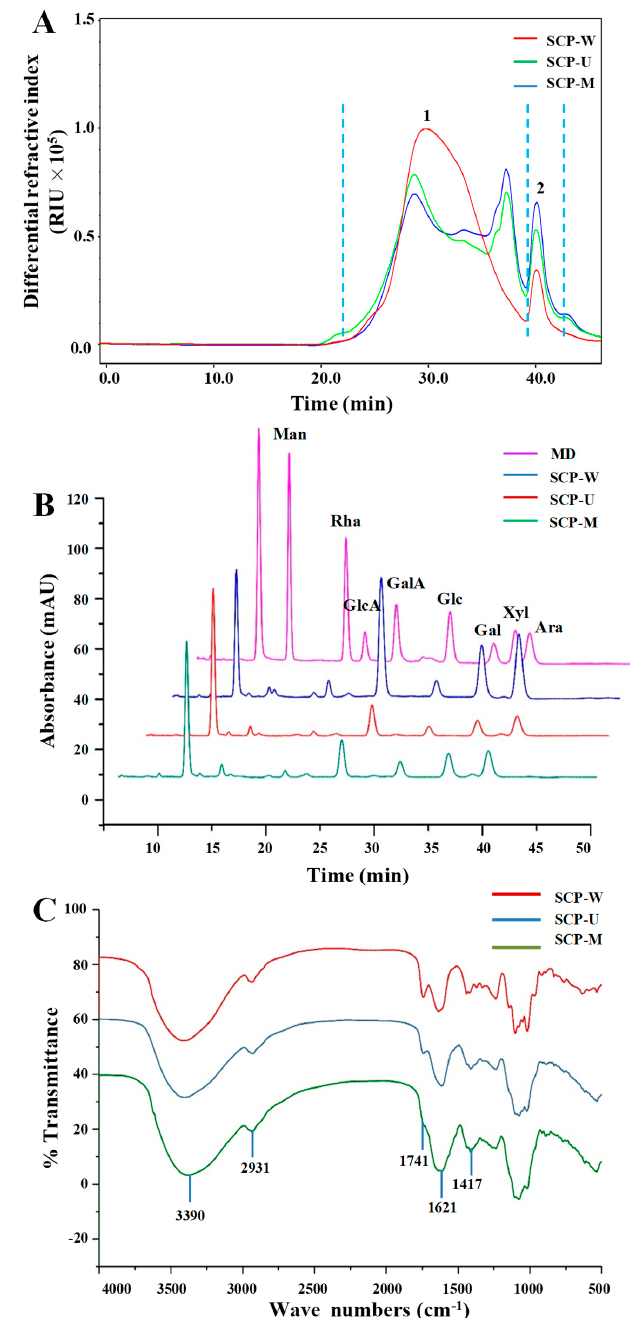
Figure 4. ( A ) High-performance size-exclusion chromatography (HPSEC) chromatograms, ( B ) high-performance liquid chromatography (HPLC) profiles, and ( C ) fourier transform infrared (FT-IR) spectra of SCP-W, SCP-U, and SCP-M; SCP-W, hot water extraction of snow chrysanthemum polysaccharides; SCP-U, ultrasonic assisted extraction of snow chrysanthemum polysaccharides; SCP-M, microwave assisted extraction of snow chrysanthemum polysaccharides; MD, mixed standard of monosaccharides; Man, mannose; Rha, rhamnose; GlcA, glucuronic acid; GalA, galacturonic acid; Glc, glucose; Gal, galactose; Xyl, xylose; and Ara, arabinose.